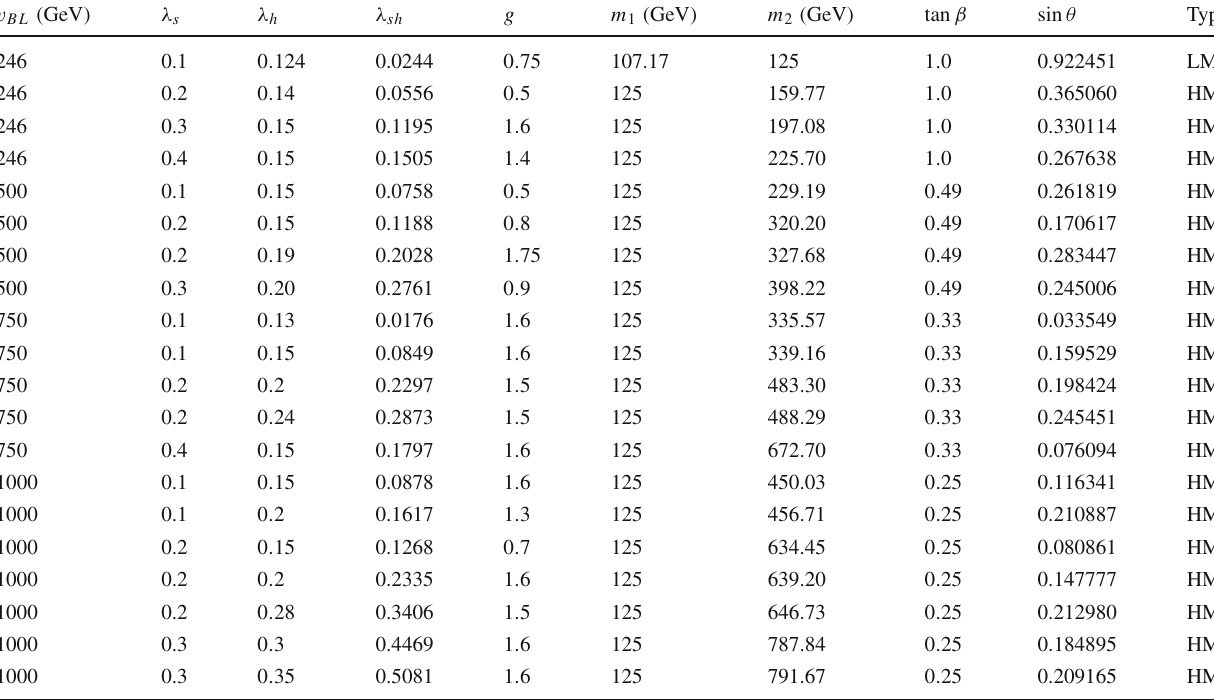
Table 3 Parameters in Fig. 5. LM: low mass region; IM: intermediate mass region; HM: high mass